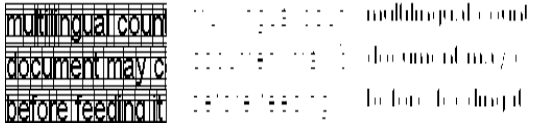
Figure 4. Sample output image of English language.